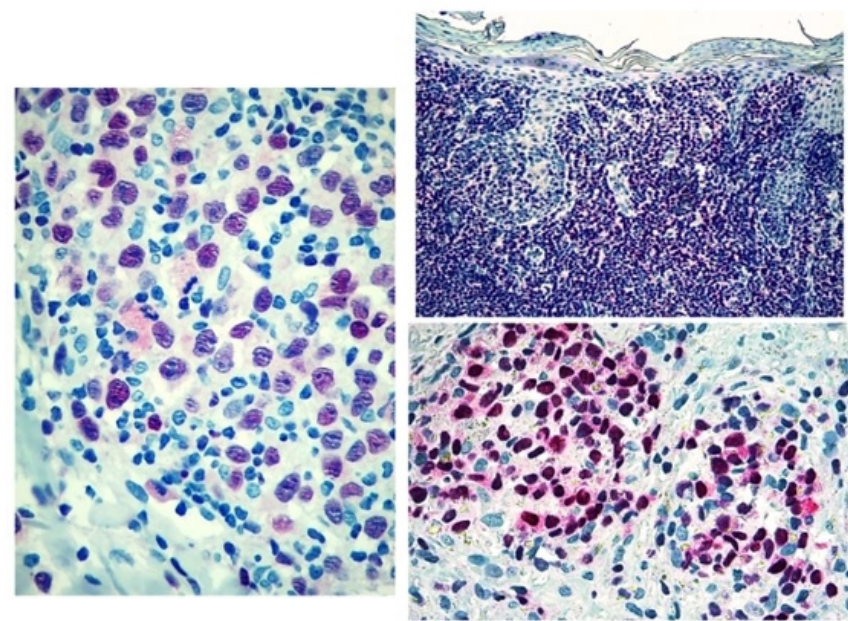
Figure 3. Score 3 Tox expression in early and advanced cases.